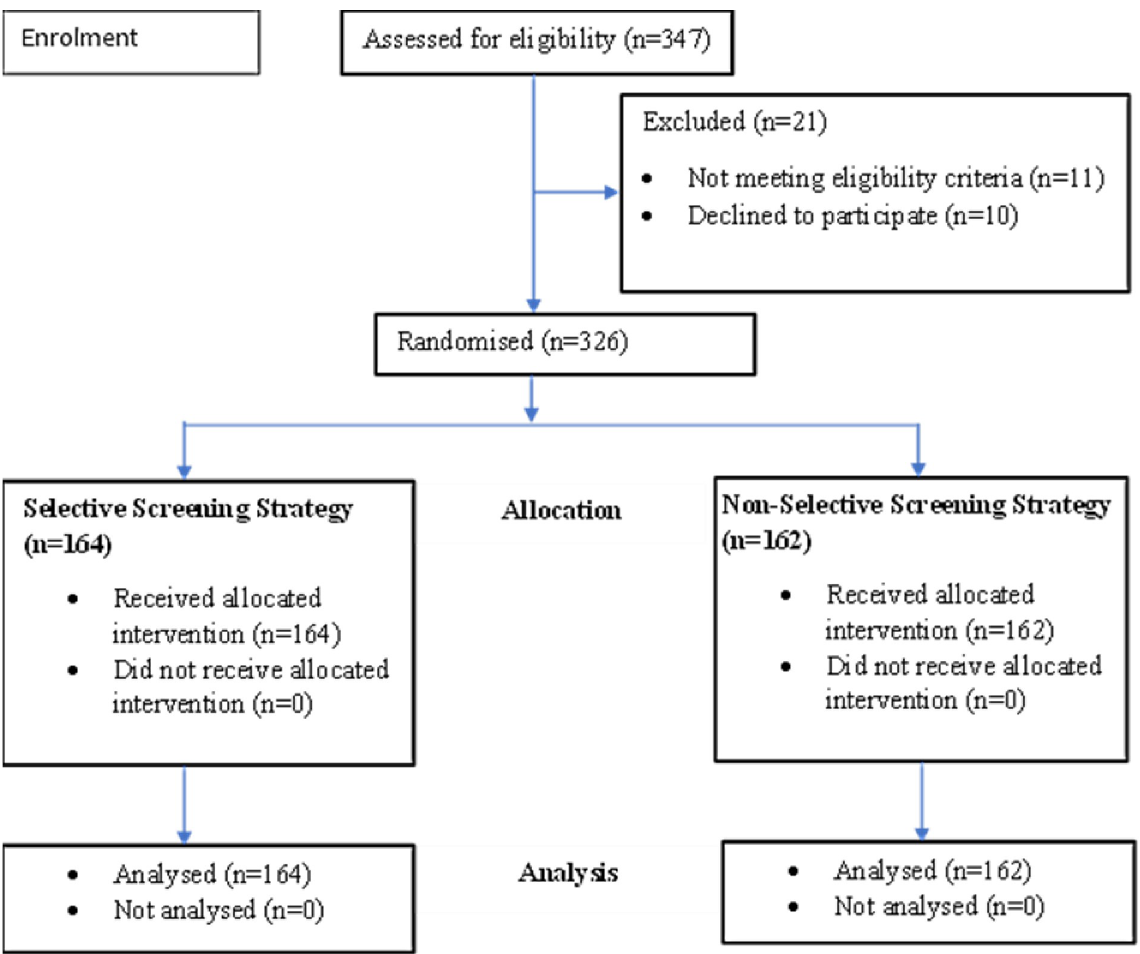
Fig 3. Study profile of PLHIV at Princess Diana Memorial Health Centre IV, Soroti District, who participated in the study from April to June